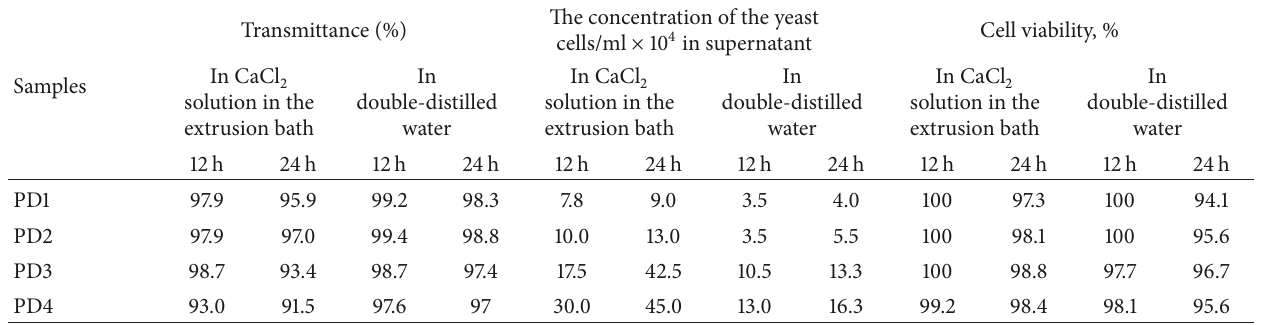
Table 3: Influence of the CaCl 2 concentration added before extrusion on the stability of the obtained particles.